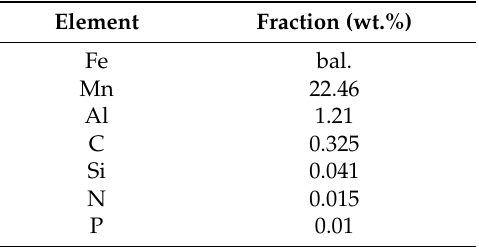
Table 1. Chemical composition of the investigated